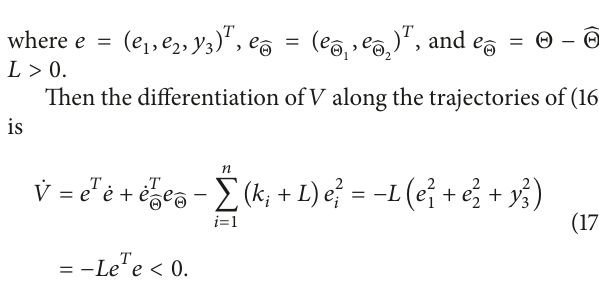
, 𝑒 ) 𝑇 , and 𝑒 ̂Θ 1 2